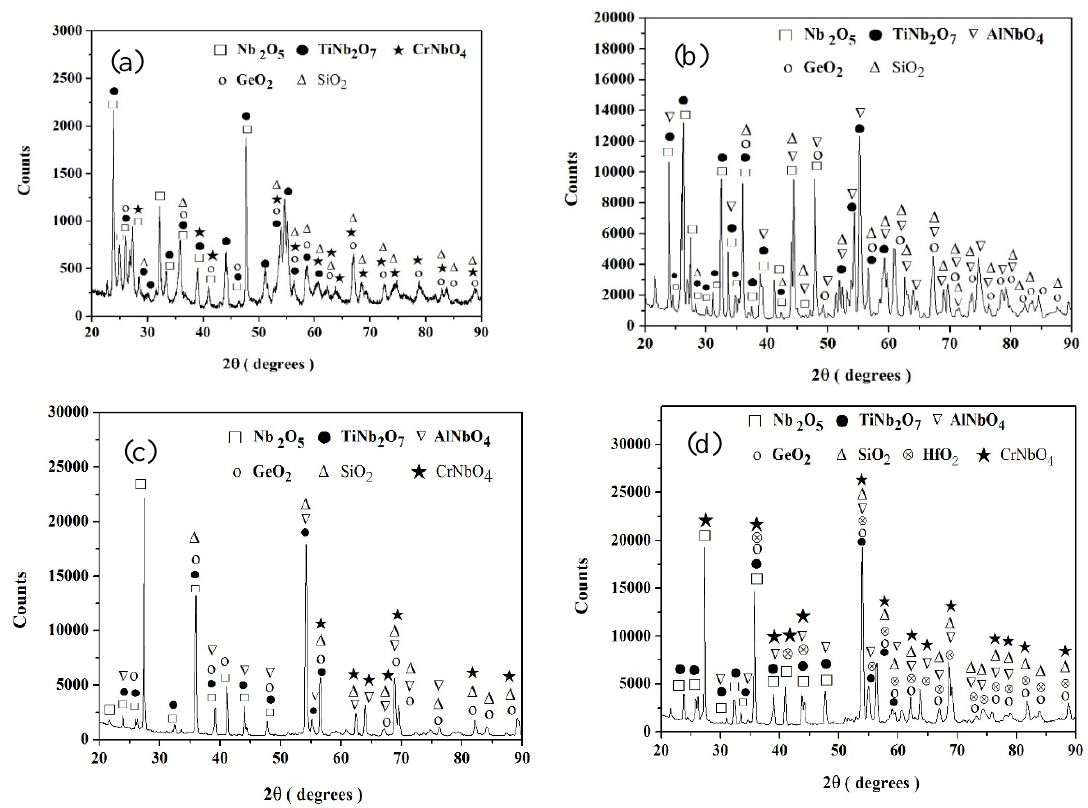
Figure 13. X-ray diffraction data of the spalled scales formed on the alloys ( a ) ZF4, ( b ) ZF5, ( c ) ZF6, and ( d ) ZF9 after 100 h at 1200 °C.